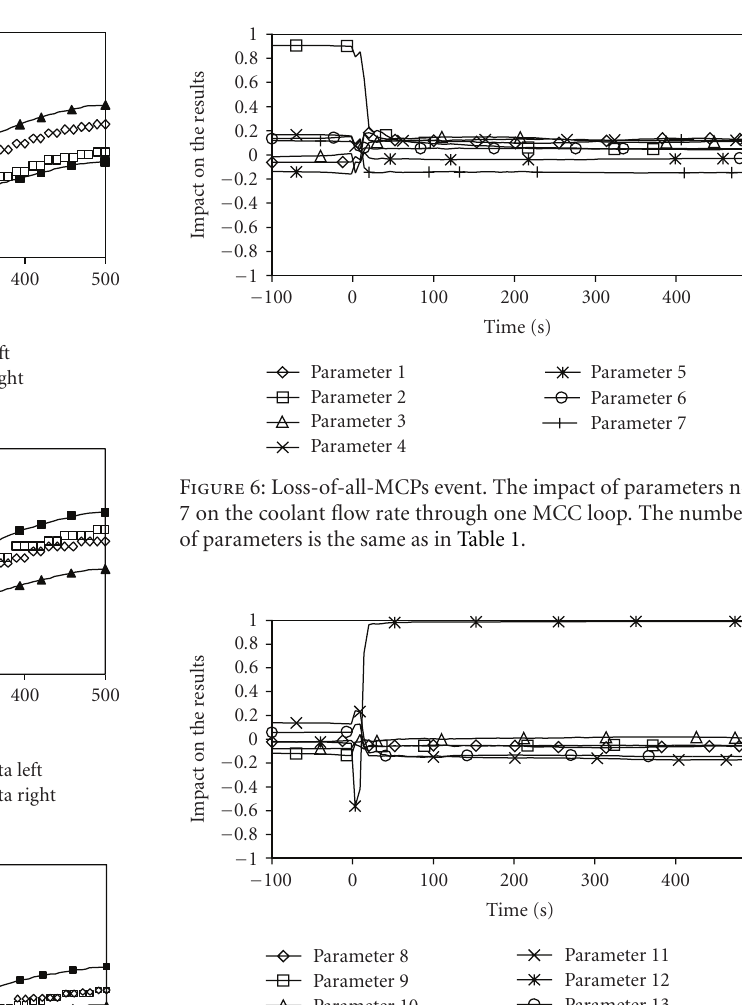
predicted, but di ff erences between the calculation and data are greater than deemed acceptable for excellent agreement.